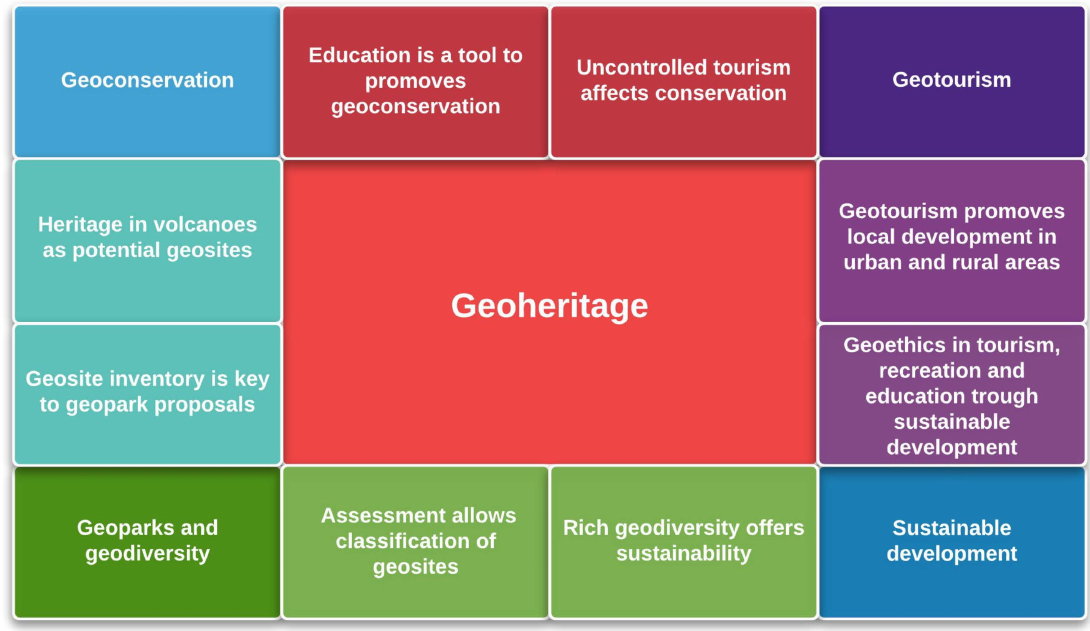
Figure 7. Synthesis of information found in the literature